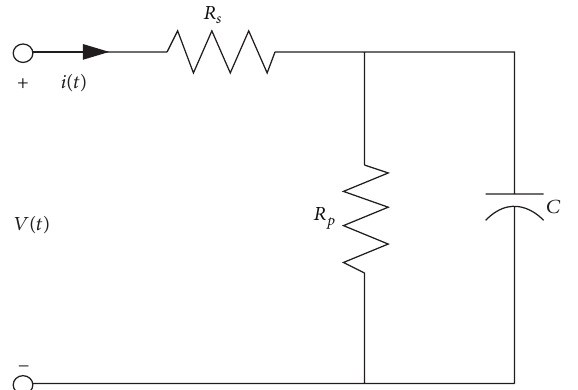
Figure 1: Equivalent electrical circuit for the polarizable electrode